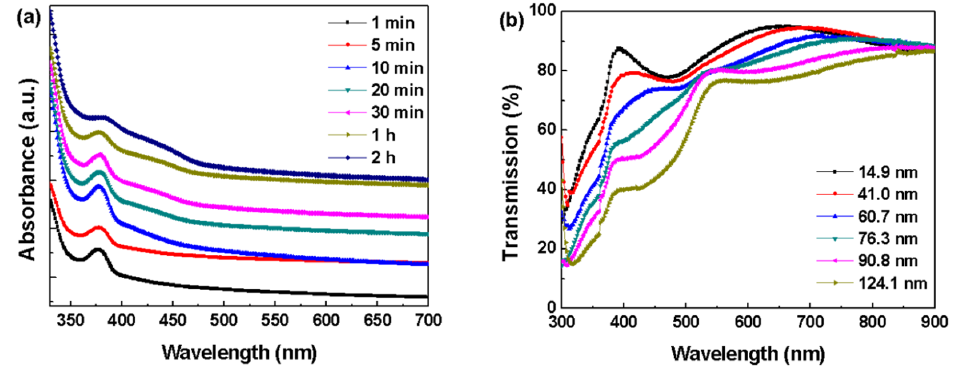
Figure 2. ( a ) UV absorbance of CdS NCs with different growth time; ( b ) Transmission spectra of ITO/ZnO/CdS with different CdS thickness.